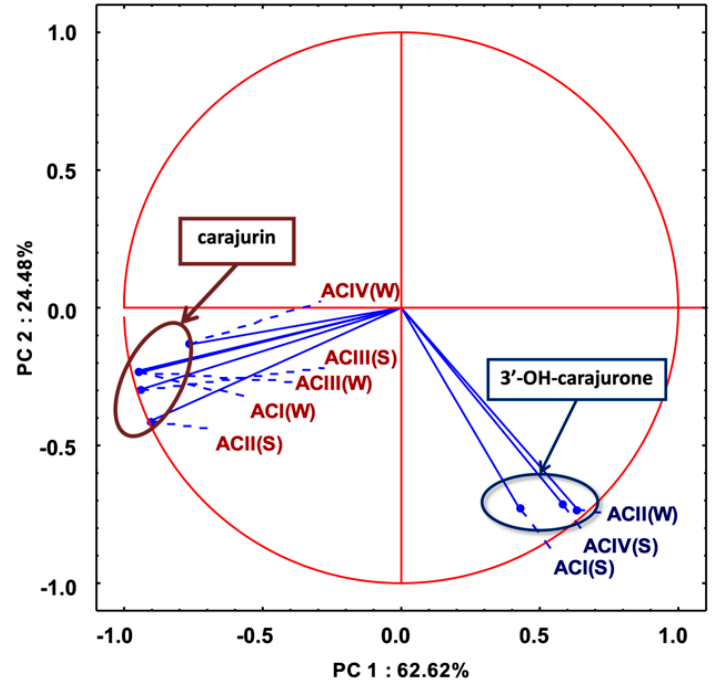
Figure 4. Unweighted air-group method with arithmetic average (UPGMA) dendrogram showing